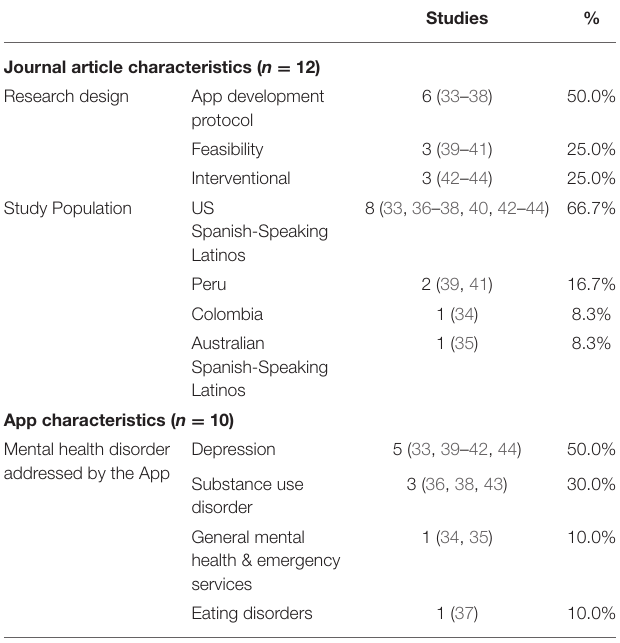
TABLE 2 | Summary metrics of studies on mental health apps in